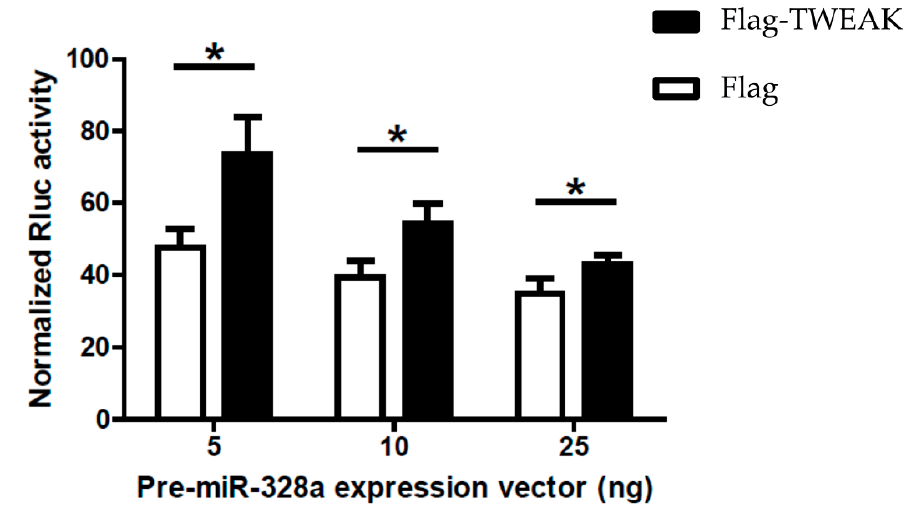
Figure 5. TWEAK impairs microRNA ‐ guided RNA silencing of a reporter gene induced by a pre ‐ microRNA. HEK 293 cells expressing Flag ‐ TWEAK (or transfected with an empty pcDNA3.1 ‐ Flag vector; Flag) were transfected with the silencing inducer pre ‐ miR ‐ 328a (or a negative pre ‐ microRNA control targeting a deleted region in Rluc ; shNEG), and a Rluc reporter gene [16] coupled with three copies of a natural miR ‐ 328a binding site in the 3 ′ untranslated region (UTR) of the Rluc reporter gene. Cells were harvested 18 h later for the successive measurements of Rluc and Fluc activities ( n = 3 experiments, in duplicate). * p < 0.05 versus Flag (empty vector) (Student’s t test).